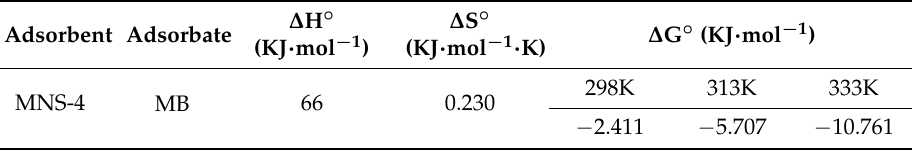
Figure 7. van ’t Hoff plot for the effect of temperature on removal of MB using MNS-4. Table 1. Thermodynamic parameters for removal of MB using MNS-4.